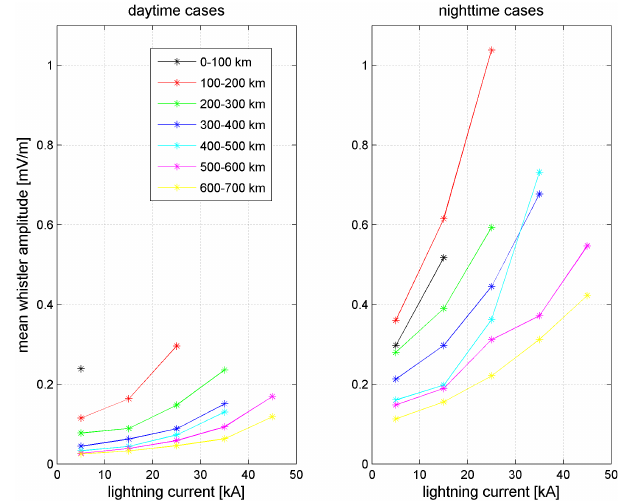
Fig. 8. Mean whistler amplitude as a function of distance between the reference point and locations of lightning for daytime cases. Green line – in-cloud discharges, red line – CG discharges. Error bars mark standart error of the arithmetic mean.